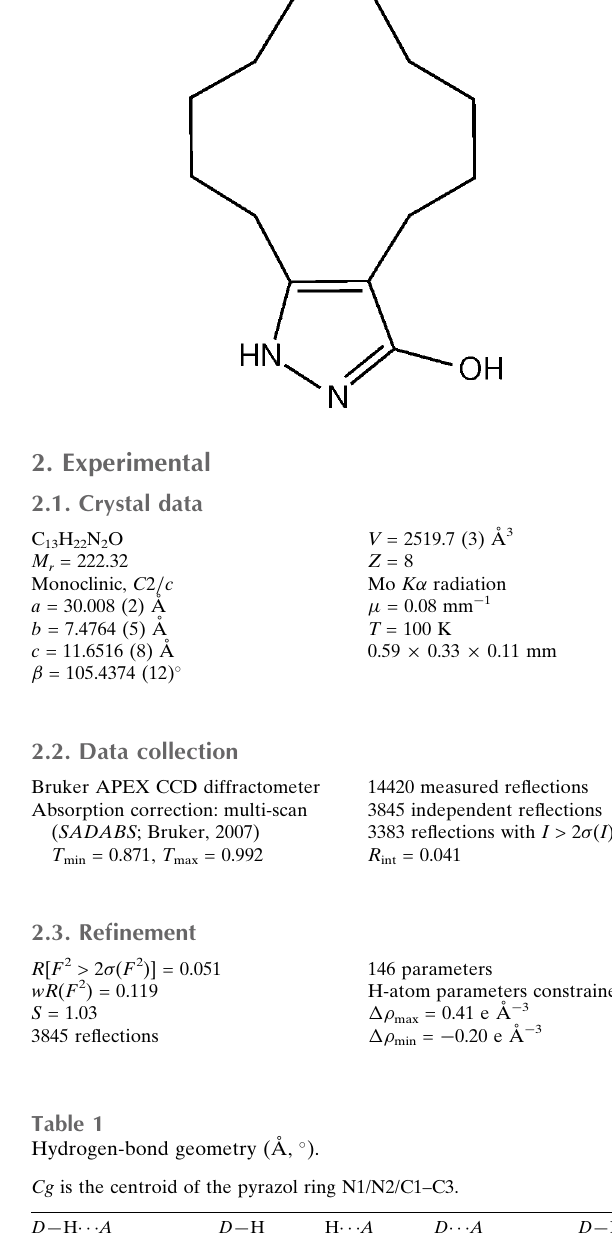
H N O, crystallized as a pyrazolol 13 22 2